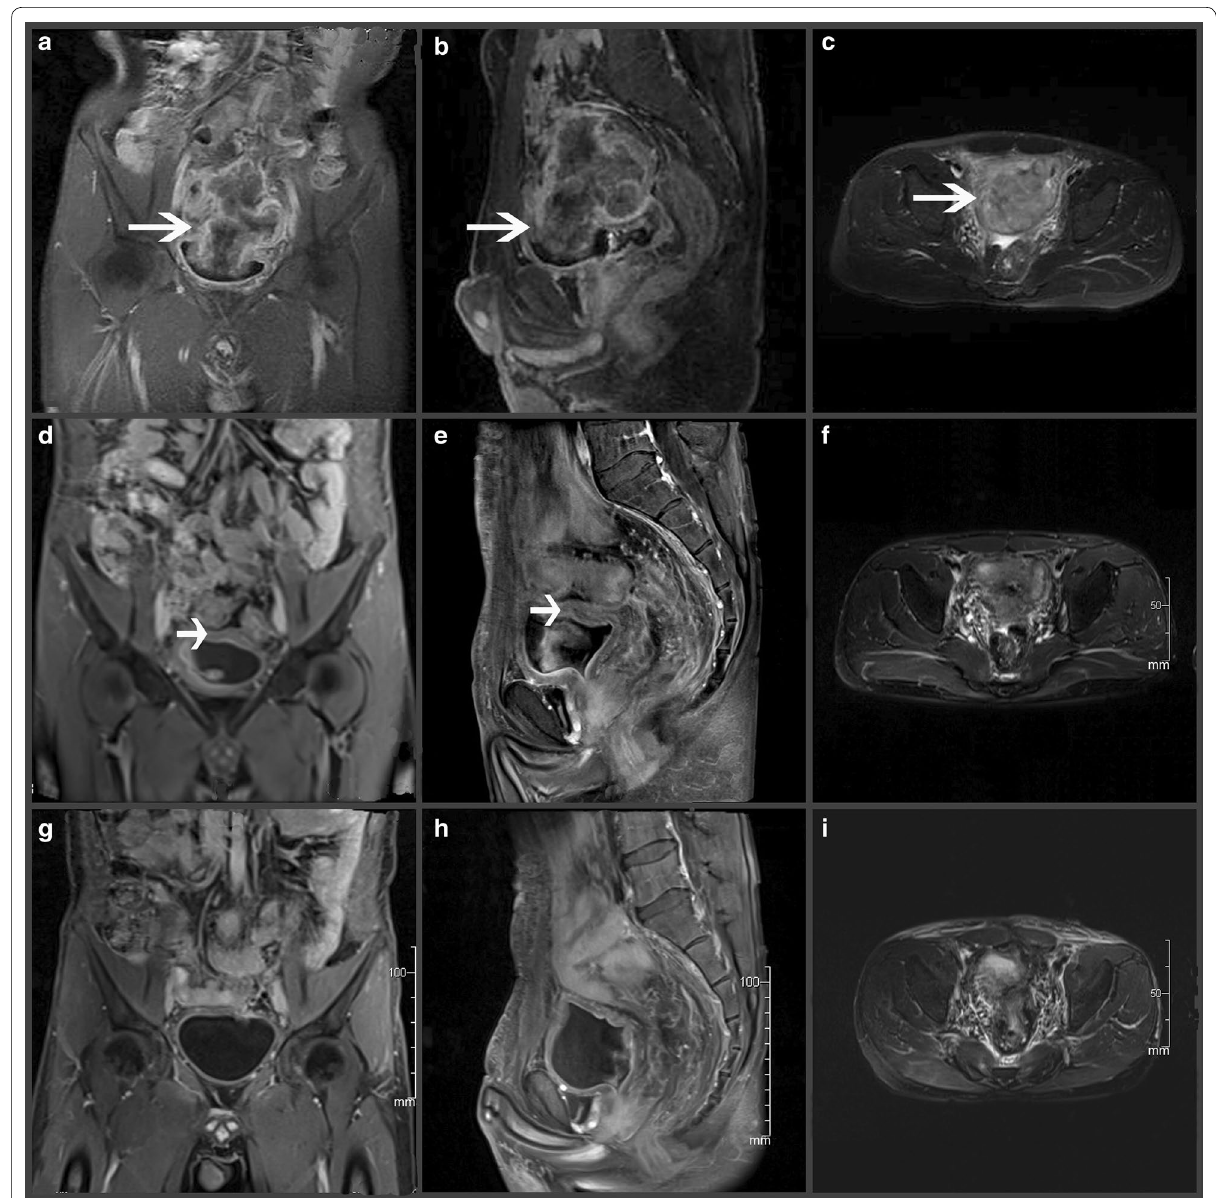
Fig. 1 The magnetic resonance imaging (MRI) scans prior to neoadjuvant chemoradiotherapy (neoCRT), after neoCRT and after colectomy in a patient with unresectable locally advanced sigmoid colon cancer (LASCC). MRI scan of the lower abdomen and pelvis before neoCRT ( a – c ), 4 weeks after neoCRT ( d – f ) and 1 month after surgical resection ( g – i ) show the lesion. Prior to neoCRT, the lesion measured 100 mm at the largest dimen‑ sion and invaded into the urinary bladder ( long arrow ). The radial margins are at risk ( a – c ). After neoCRT, substantial down‑sizing of the lesion and improvement of all the margins were observed. The upper bladder wall ( short arrow ) remains thick ( d – f ). After colectomy and partial cystectomy, the lesion was removed completely. Bladder structure is well preserved ( arrow head ) ( g – i ). ( a , d , g , coronal T1‑weighted with contrast; b , e , h , sagit‑ tal T1‑weighted with contrast; c , f , i , cross